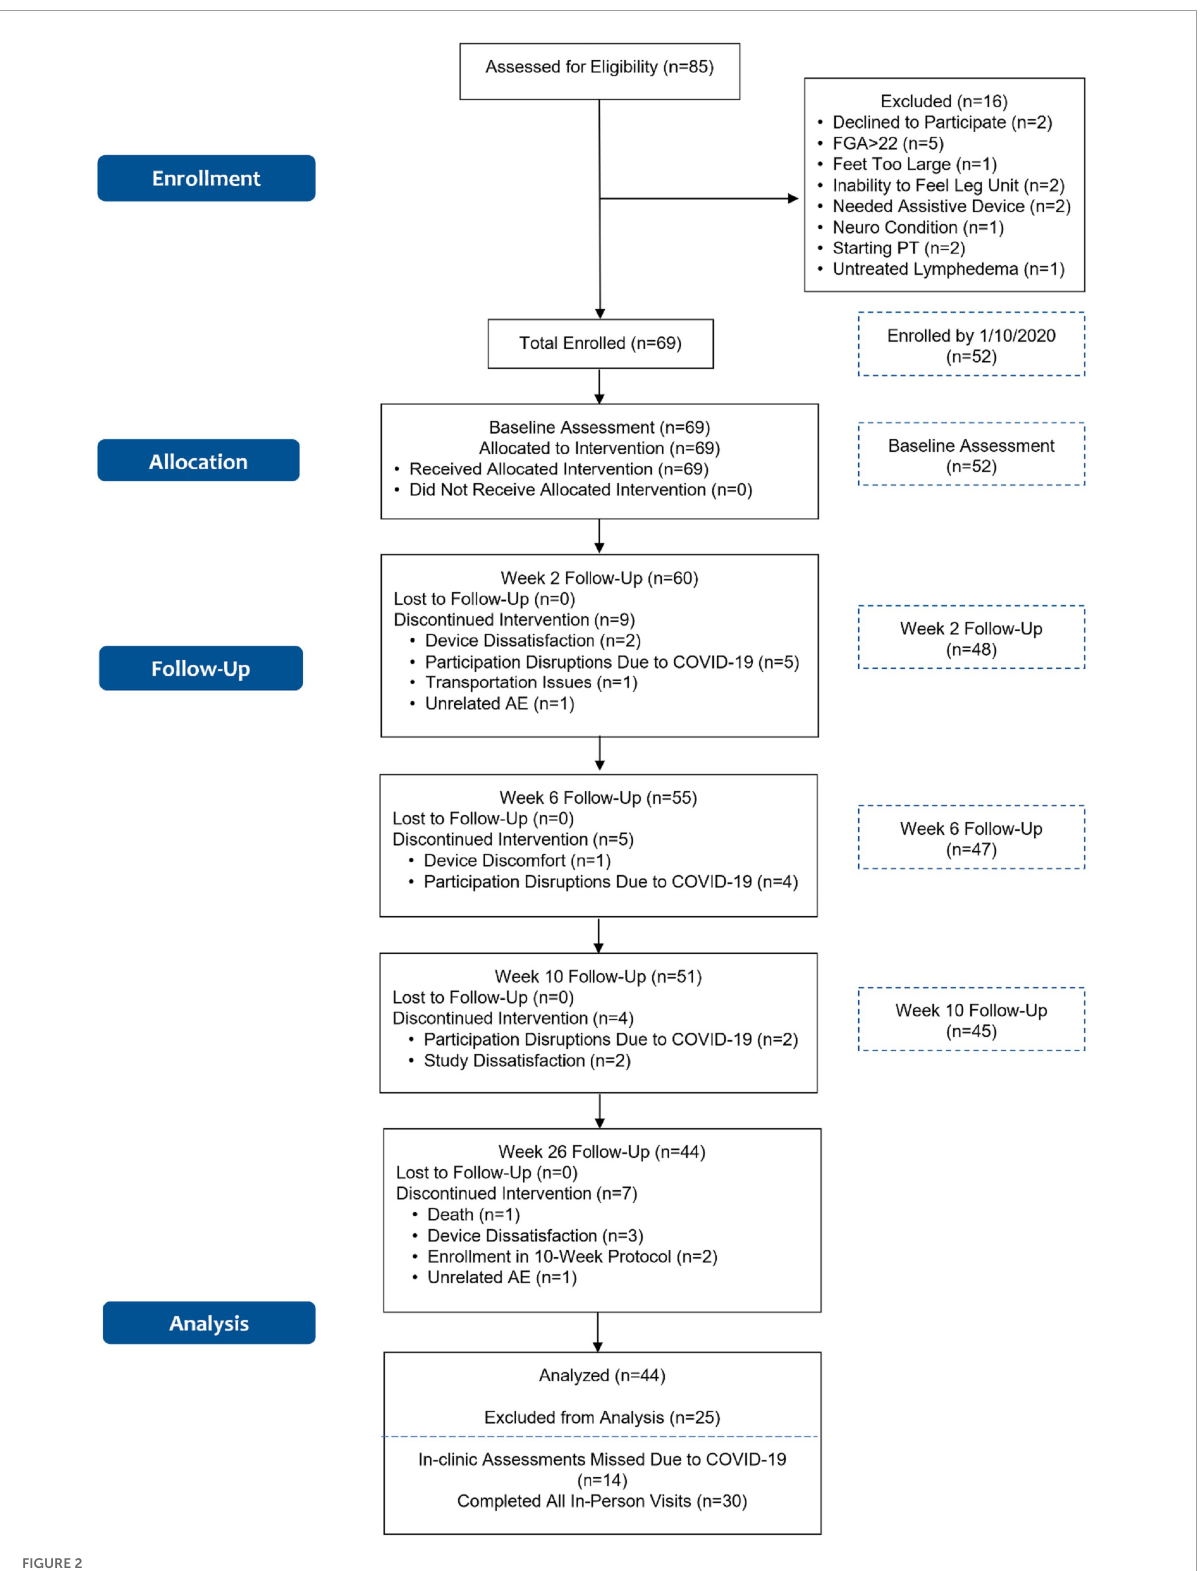
FIGURE2 Flowchart of the walk2Wellness trial. Data for the primary endpoint at 10 weeks, shown to the right for reference, were published earlier (Oddsson et al., 2020). Due to COVID-19 site lockdowns, in-person outcomes could be assessed from 30 of the 44 participants. Self-reported outcomes and fall events were assessed from all 44 participants who reached the 26-week follow-up